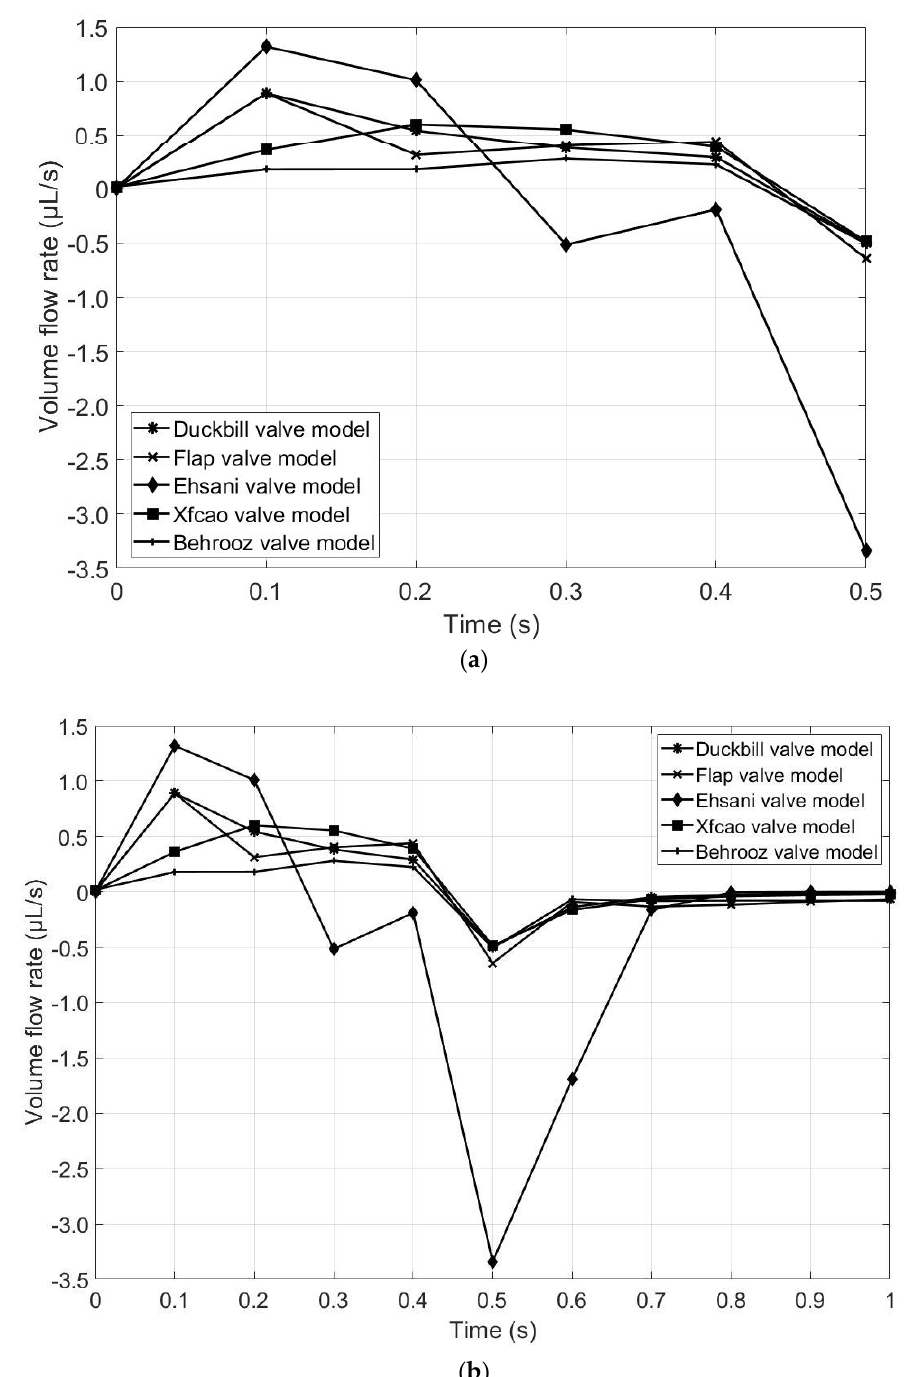
Figure 13. Comparison of volume flow rates for the five valve models: ( a ) contraction phase (until t = 0.5 s) and ( b ) both expansion and contraction phase (until t = 1 s).